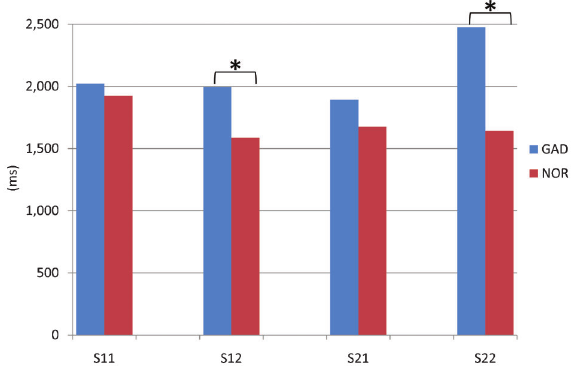
Figure 2. Comparison of reaction time under S negative/negative , S negative/neutral , S neutral/negative , and S neutral/neutral conditions between patients with generalized anxiety disorder (GAD) and normal controls. *P , 0.05, post hoc Neuman-Keuls comparisons test.